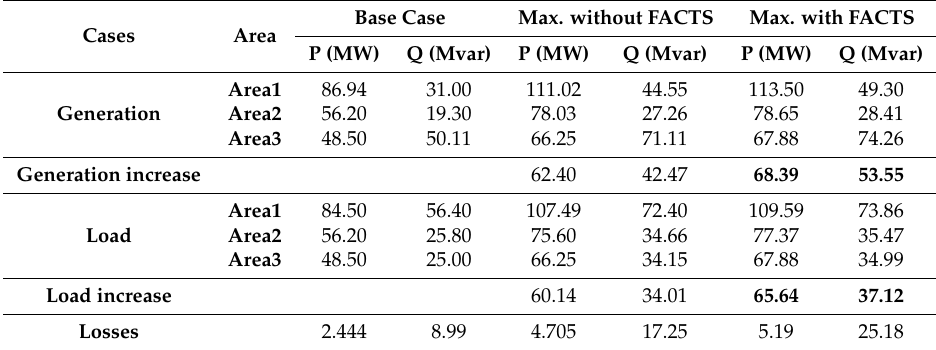
Table 4. Load and generation of IEEE 30 bus